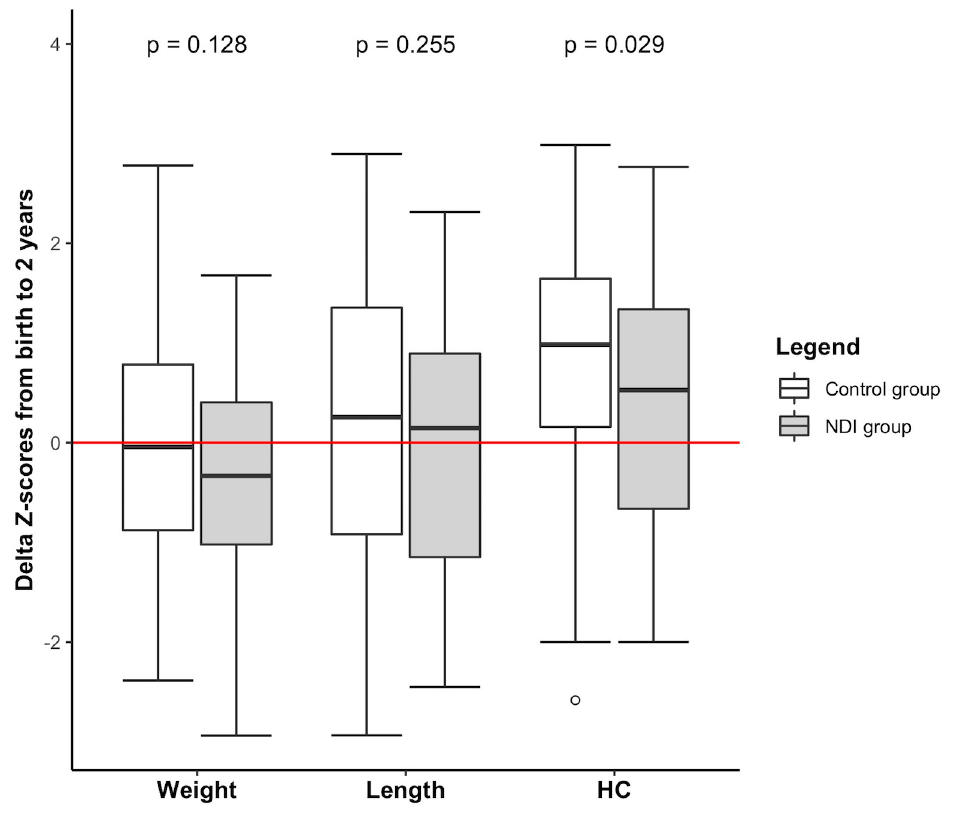
Fig 2. Delta Z-scores between the birth and 2 years’ CA. CA: corrected age. HC: head circumference. NDI: neurodevelopmental impairment. Z-scores at birth are based on Olsen curves [13]. Z-scores at 2 years’ CA are based on World Health Organization child growth standards [14]. Delta Z-score is the difference between the 2 years Z-score and the birth Z-score. Comparison with Mann-Whitney U test, alpha = 0.05.